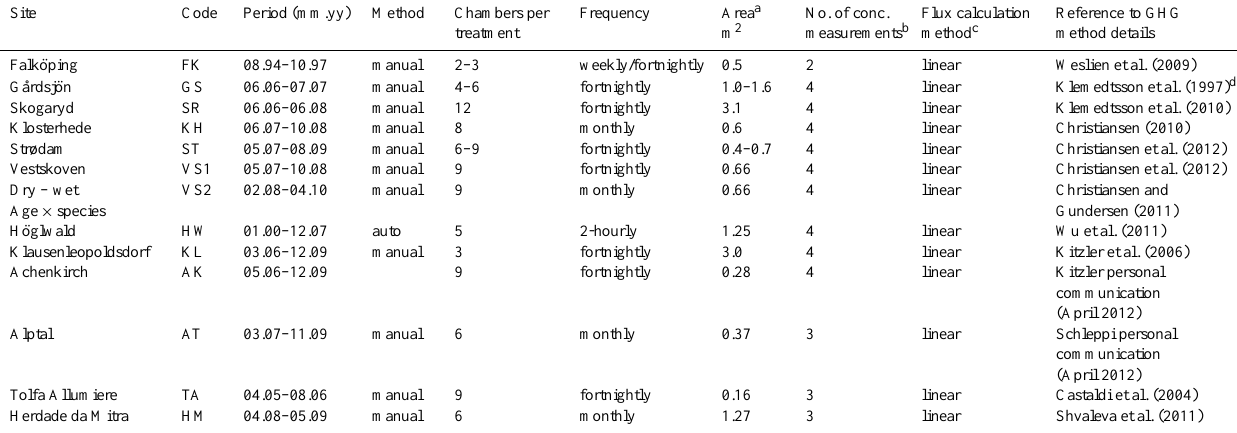
Table 2. Methods for determination of GHG